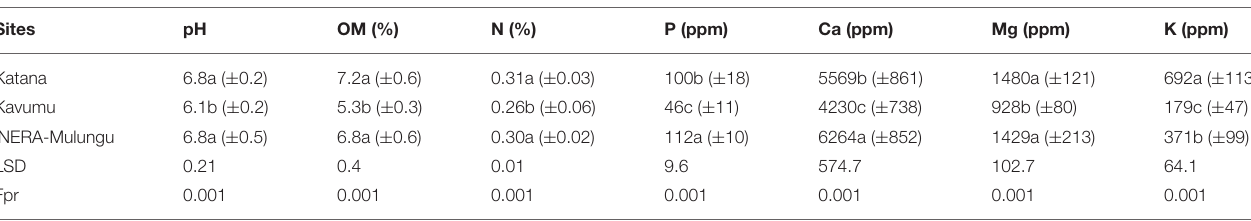
TABLE 1 | Soil characteristics at Katana, Kavumu and INERA-Mulungu.